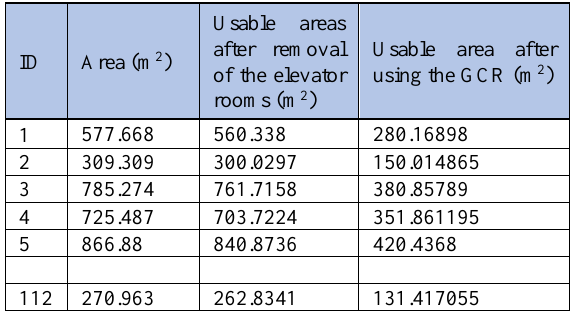
Table 1 . An example of the rooftops’ areas before and after removing all the obstructions.